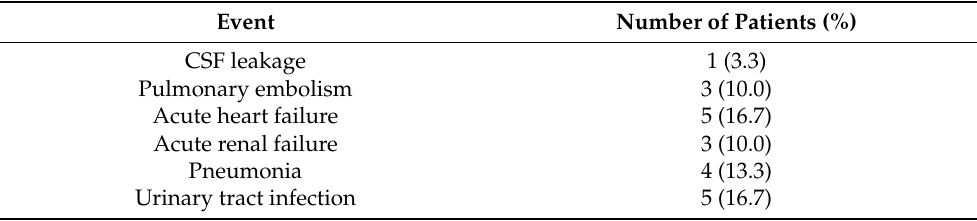
Table 3. Occurrence of adverse events in the octogenarian patients ( n = 30) who underwent decom- pression surgery.